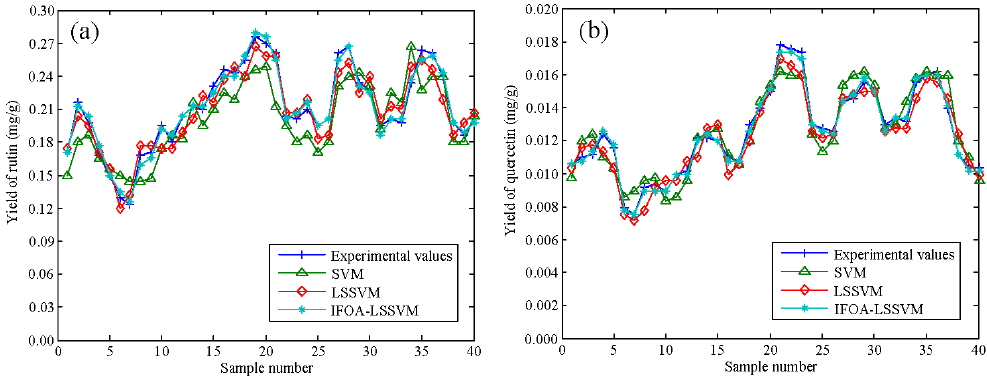
Figure 11. Prediction performance of different models on the test dataset of: rutin ( a ); and quercetin ( b ). Table 3. Prediction performance of different models on the generalization dataset of analytes.